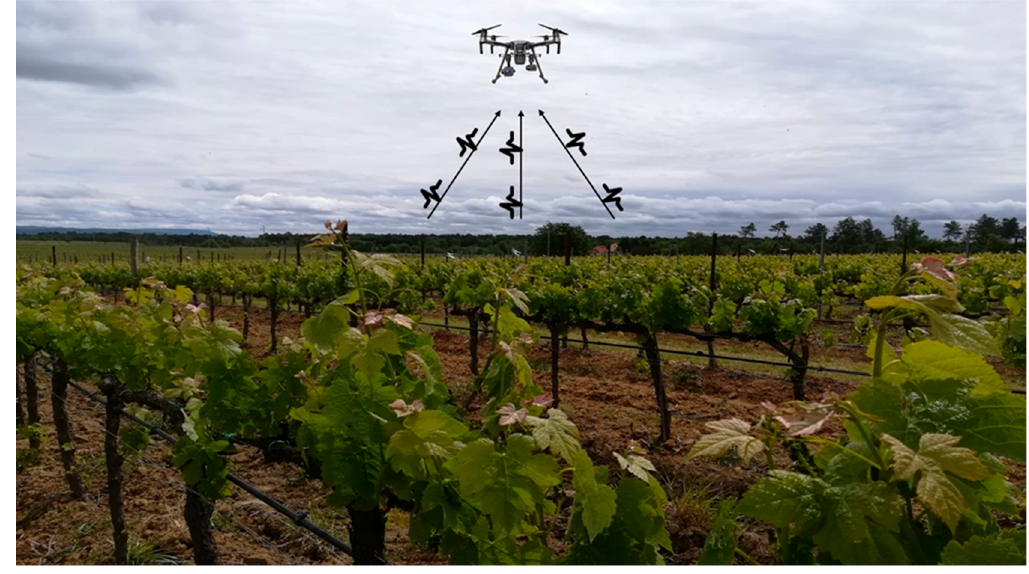
Figure 4. Data collection of HT box sensors from a vineyard using a far wake-up device represented by a drone.